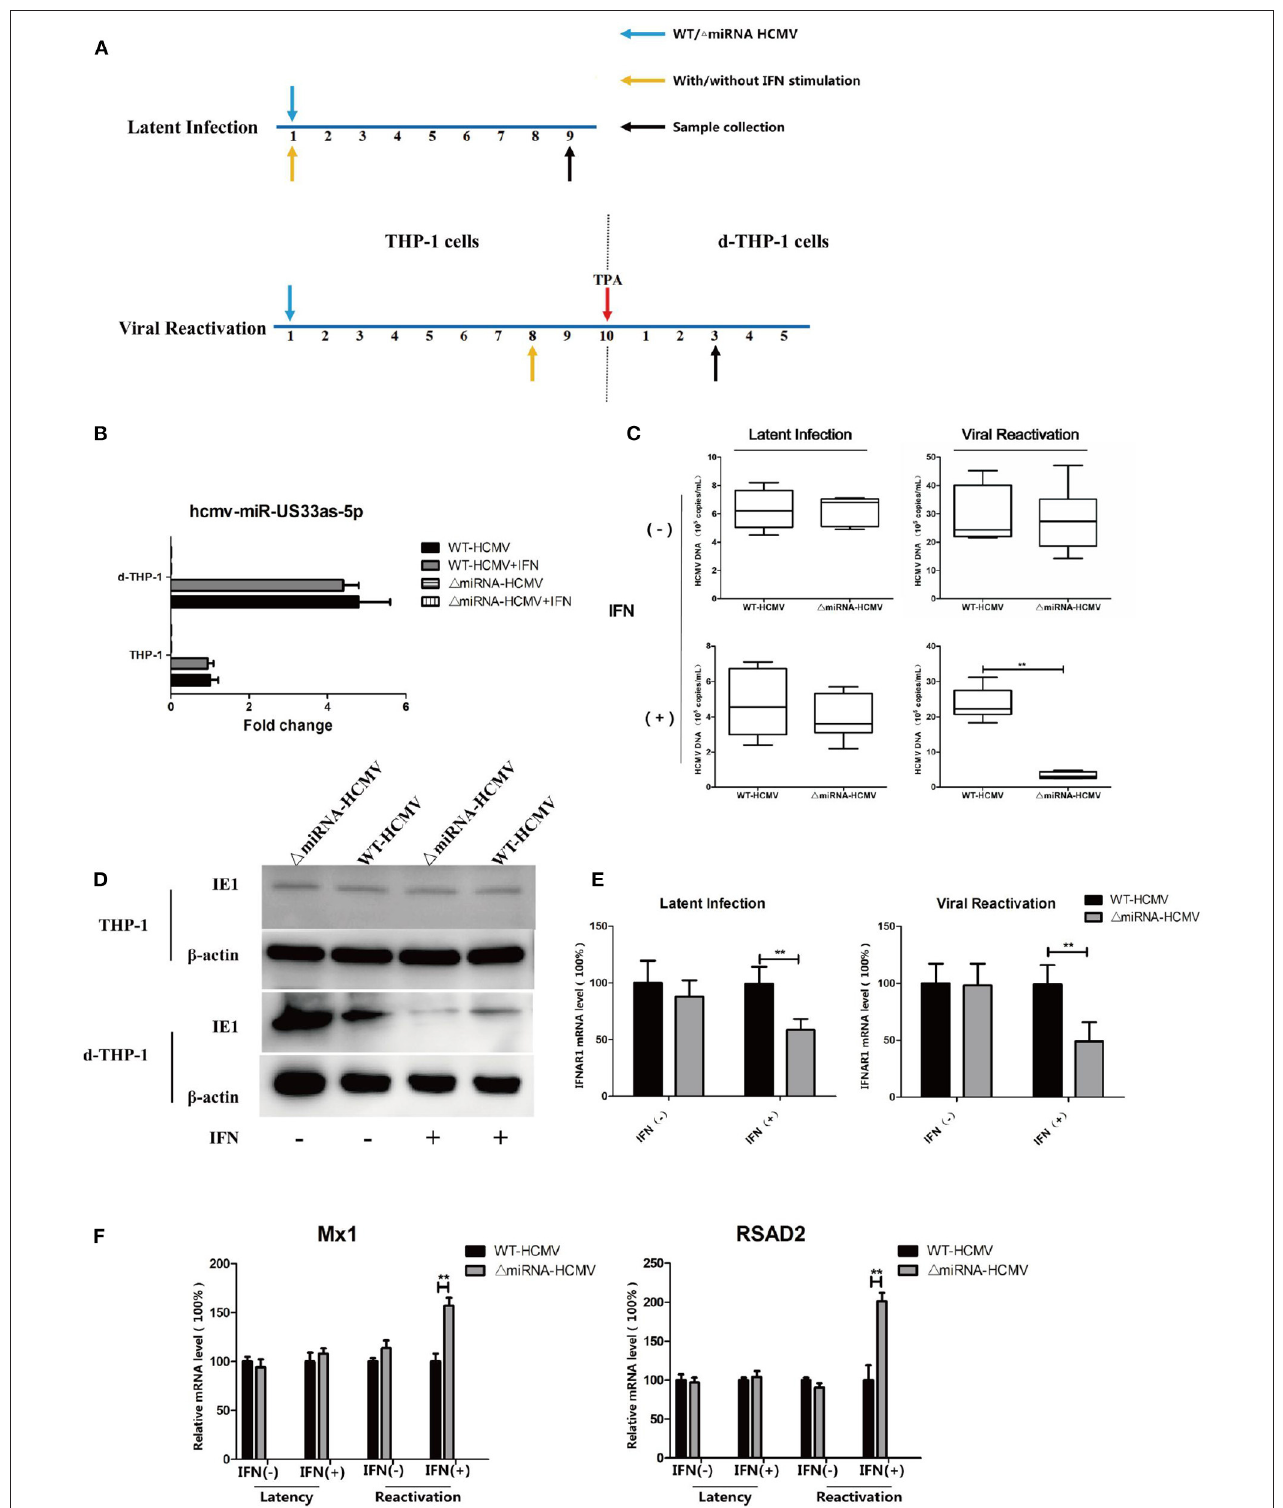
FIGURE 8 | A lack of hcmv-US33as-5p impaired viral resistance to the IFN pathway during latency and reactivation. (A) A schematic diagram depicting the in vitro models of latent infection and viral reactivation. For latent infection, THP-1 cells were infected with WT or 1 miRNA HCMV (MOI = 10) and maintained for 9 days in